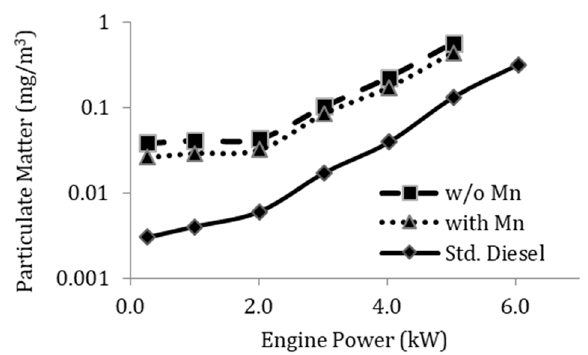
Figure 8. Effect of organic-based Mn additive on particulate matter.